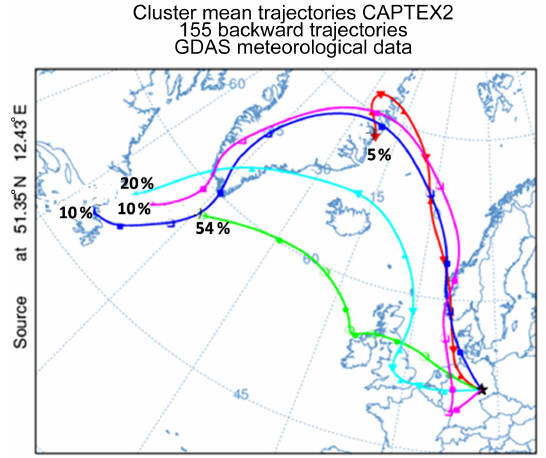
Figure 8. Cluster analysis of the HYSPLIT back trajectories that arrive every hour (from 23 September 12:00UTC up to 24 Septem- ber 18:00UTC) at 2.5–3.5km height over Leipzig. A 54% cluster percentage means that there is 54% chance that the SO 2 arriving anywhere between 2.5 and 3.5km over Leipzig originates from the specific direction.